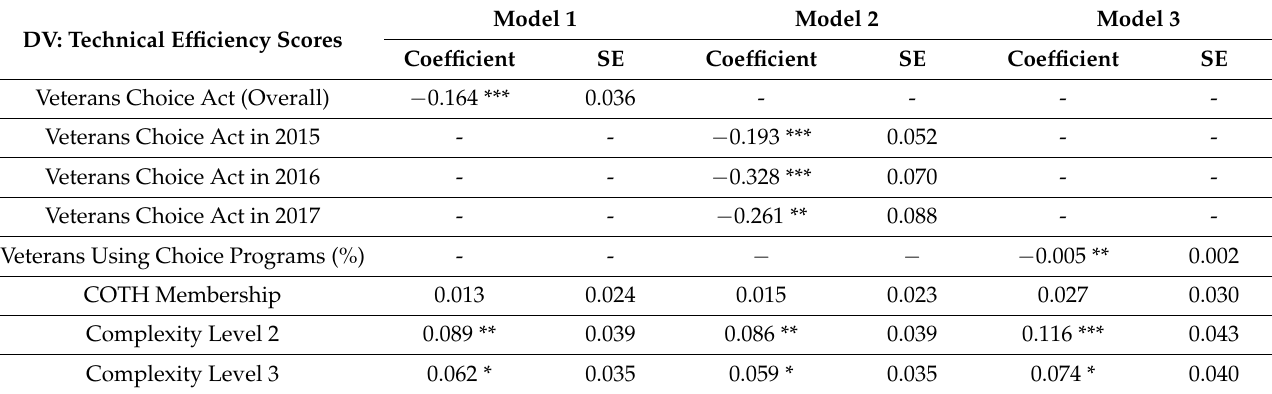
Table 4. Results from cross-sectional time-series tobit